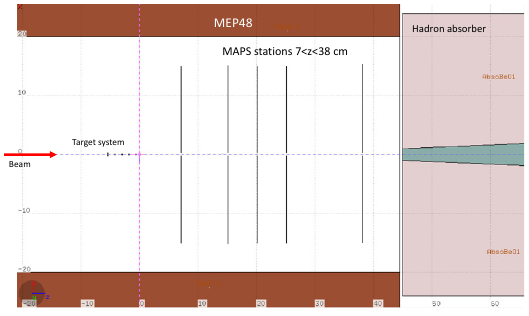
Figure 1. Conceptual design of the NA60 + experimental apparatus. The figure represents the set-up Figure 2. Schematic layout of the silicon planes inside adapted to low-energy collisions, with a thinner hadron absorber and the muon spectrometer relatively closer to the target.